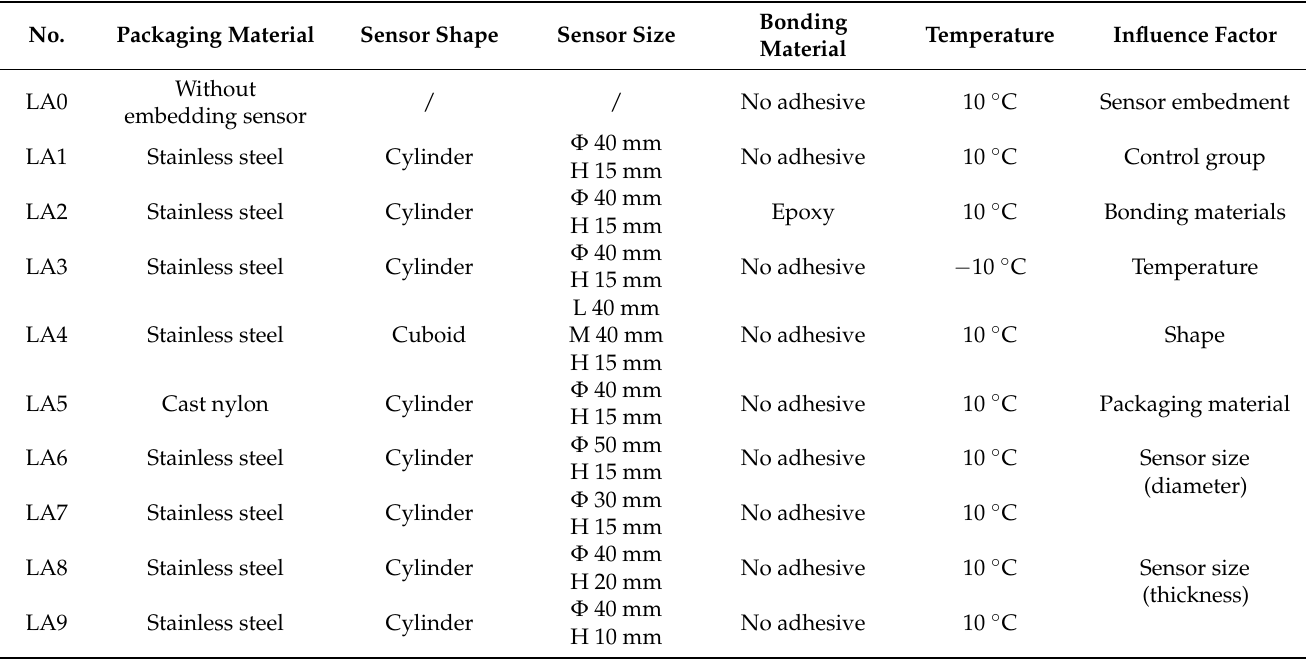
Table 1. Designed test conditions.